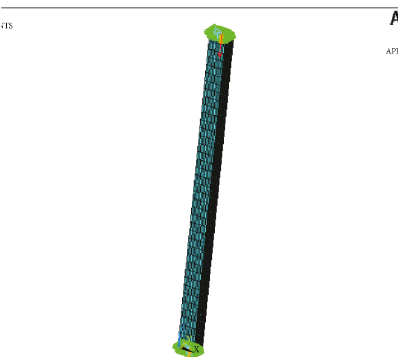
Figure 7: Basic finite element model.